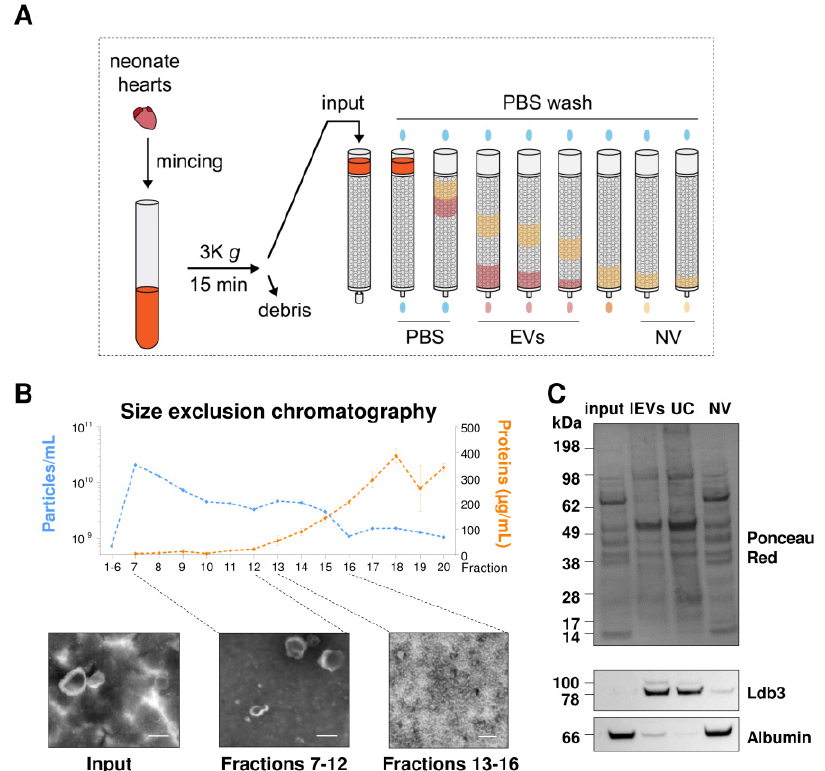
Figure 4. Ldb3 is a specific marker of cardiac EVs. ( A ) Protocol of size exclusion chromatography (SEC) to separate EVs from non-vesicular factors (NV). K: × 1000. ( B ) Graph representation of NTA particle count (blue) and protein concentrations (orange) for each SEC fraction. Representative transmission electron microscopy images of unpurified EVs (solution obtained after centrifugation at 3000 × g ) and different pools of SEC fractions (7–12 and 13–16) are presented below. Scale bars = 150 nm. ( C ) Quantification of Ldb3 and albumin by Western blot of EVs obtained by differential ultracentrifugation (UC) and in SEC fraction 20 (NV).